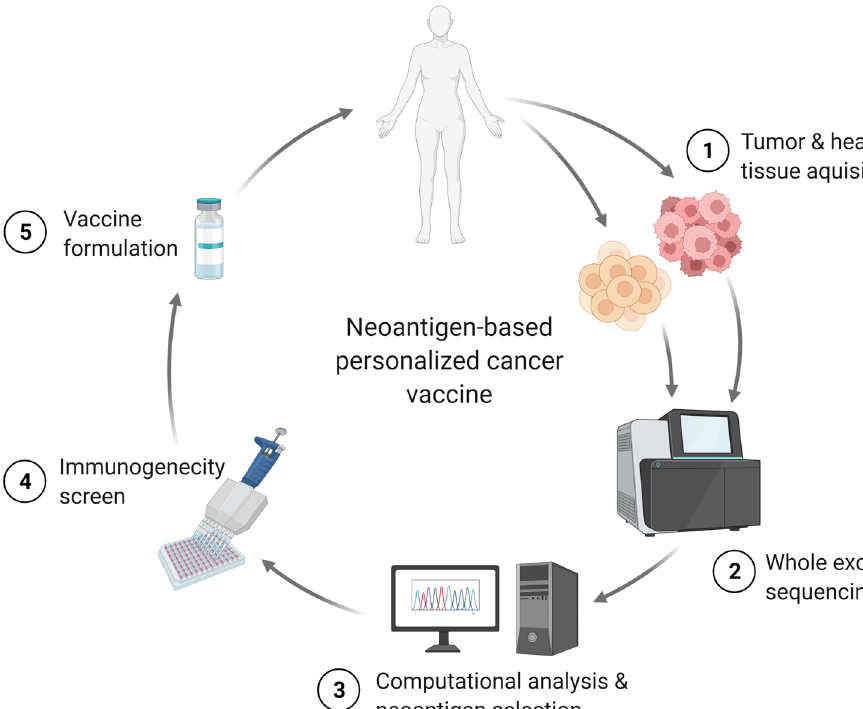
Fig. 2 Personalized neoan- tigen-based cancer vaccine. Neoantigens are recognized by whole exome sequenc- ing of tumour genome and comparing it to the sequences from normal tissue. Identified neoantigens are screened for immunogenicity and used in vaccine preparation to immu- nize the